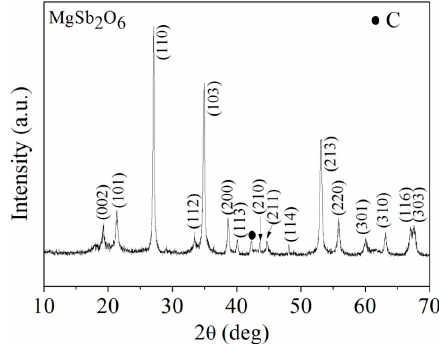
Figure 2. X-ray diffraction pattern of MgSb 2 O 6 powders calcined at 800 °C and prepared by the colloidal method.